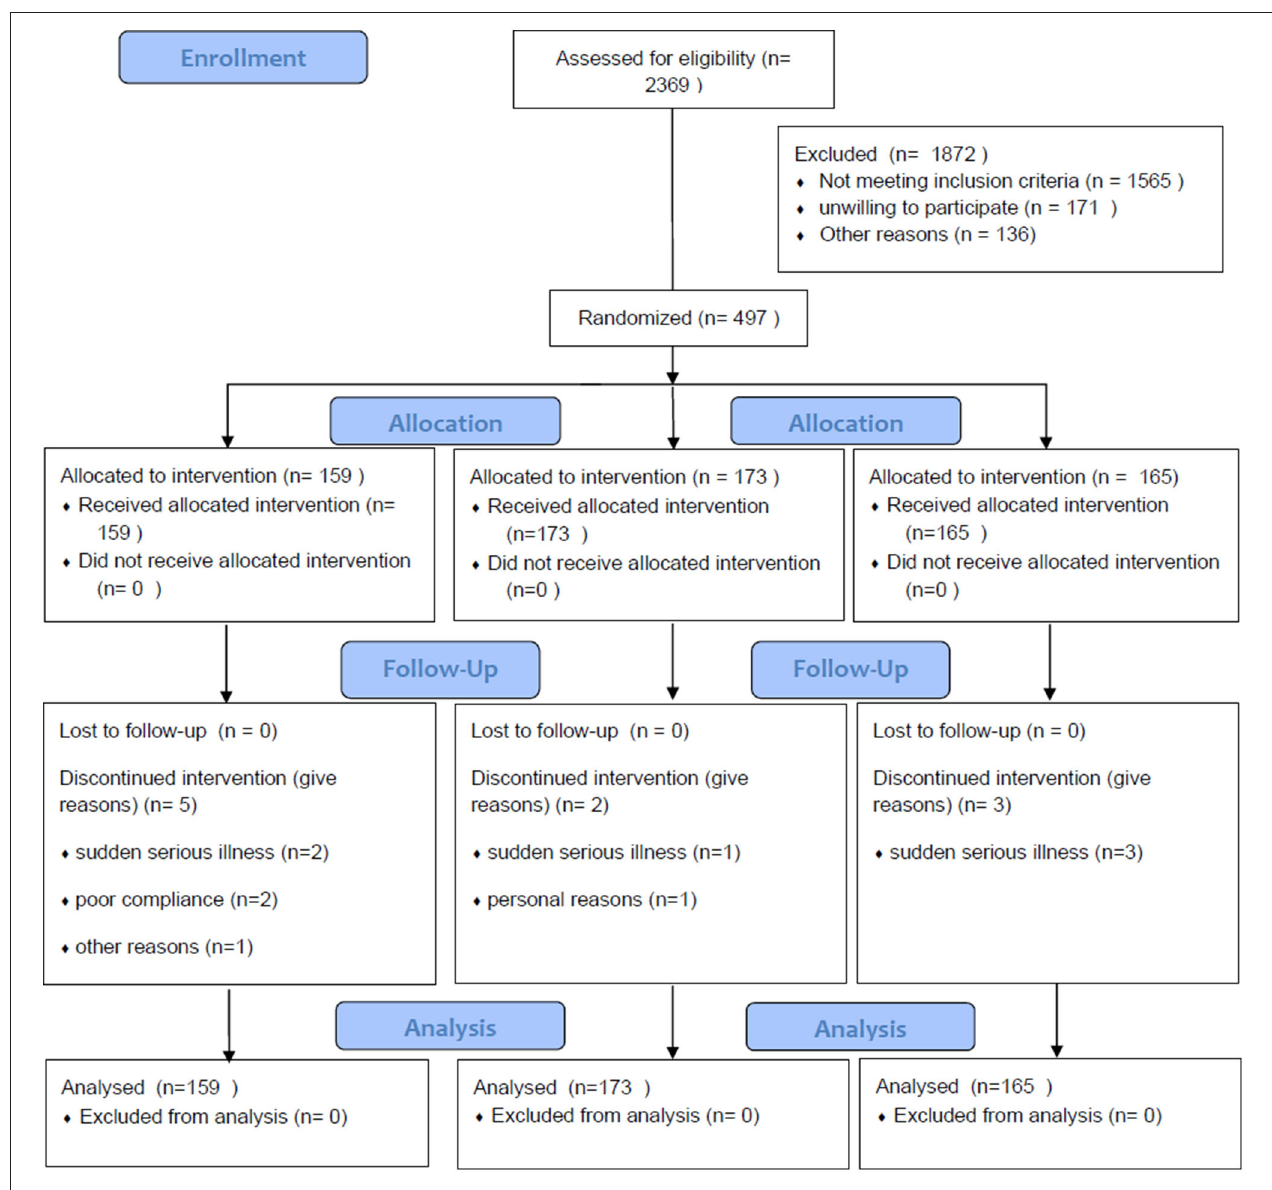
FIGURE 1 | Flow diagram showing the study